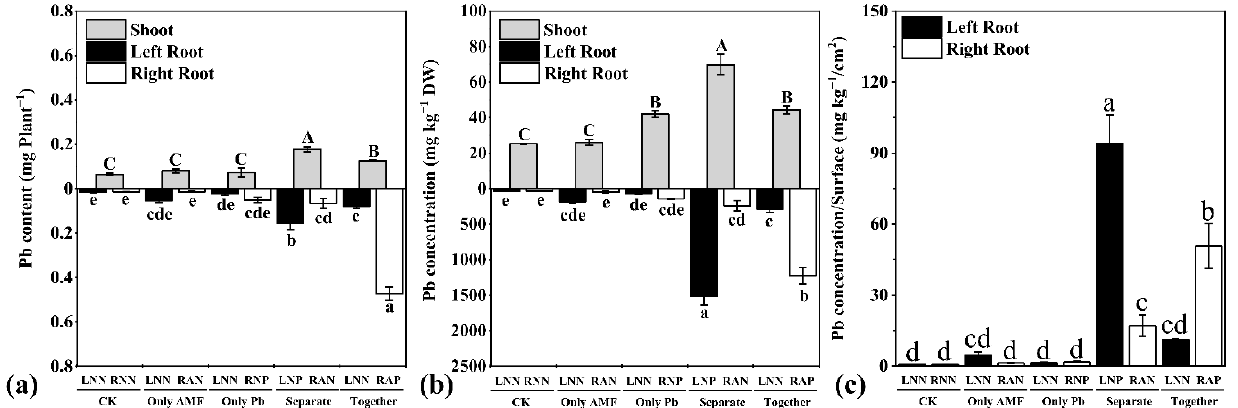
Figure 4. The Pb content ( a ), total Pb concentration ( b ), and the ratio of Pb concentration to surface ( c ) in M. truncatula plants in different treatments. The data are the means ± standard error ( n = 3). Different uppercase and lowercase letters above the columns indicate significant differences among the means by LSD test ( p < 0.05), respectively. The abbreviations are consistent with Figure 1.